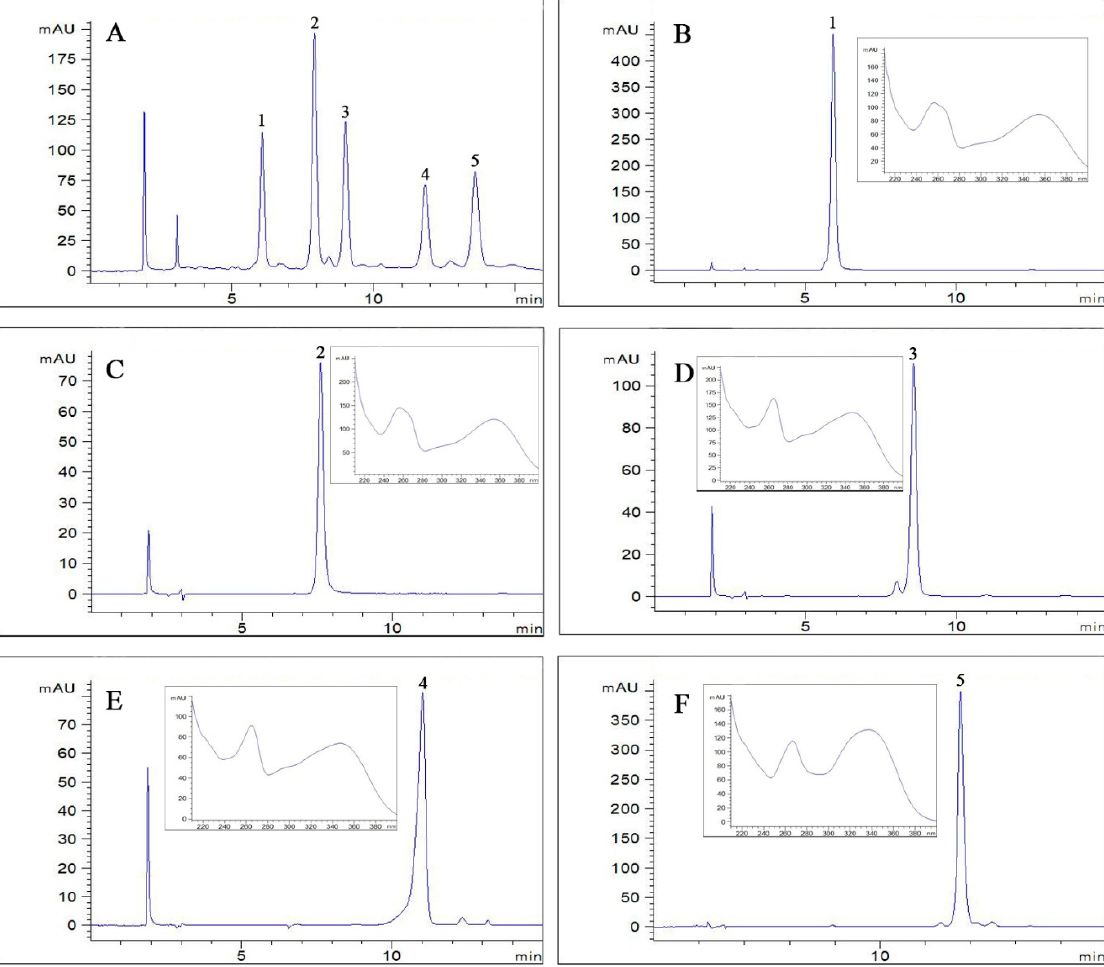
Figure 3. ( A ) HPLC analysis of the crude sample; ( B – F ) HPLC chromatograms and UV spectra of compounds 1 – 5 . Column: C18 column (Waters symmetry, 5 µ m, 4.6 mm × 250 mm, i.d.); mobile phase: acetonitrile ( A ) 0.1% aqueous solution of formic acid (B) (0–15 min, 21:79, v / v ); flow rate: 1.0 mL / min; detection wavelength: 254 nm; column temperature: 25 °C.